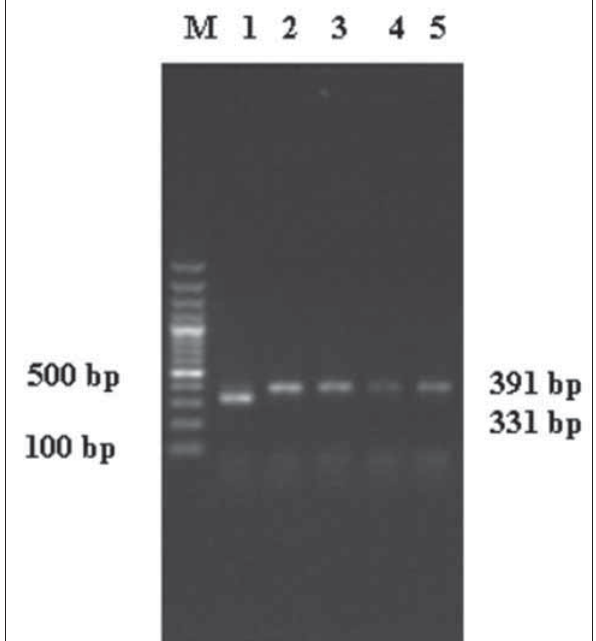
Figure-1: Electrophoresis of lpx A gene mPCR products on 2.0% agarose. Lane M: 100 bp DNA ladder, Lane 1 and 2: Positive controls, Lane 3-5: Samples with positive amplicon. http://apps.who.int/iris/bitstream/10665/80751 /1/9789241564601_eng.pdf. 14 % increase http://www.